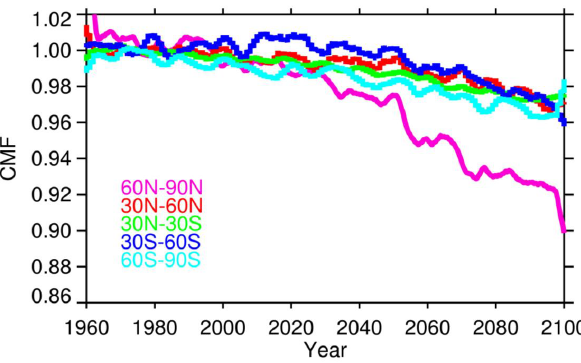
Fig. 14. Cloud modification factor (CMF) changes relative to the 1970–1979 average. A decrease in CMF corresponds to a decreased cloud transmission, i.e., a decrease in transmitted solar radiation to the